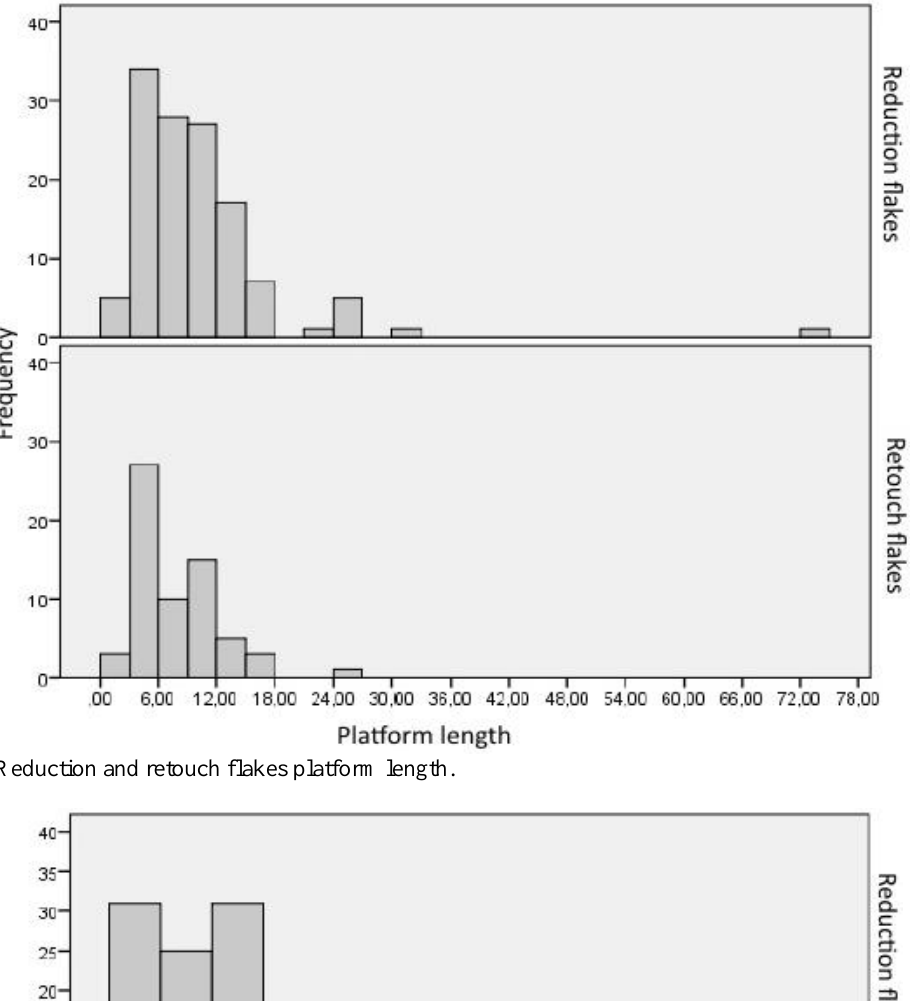
Figure 10. Reduction and retouch flakes platform length.